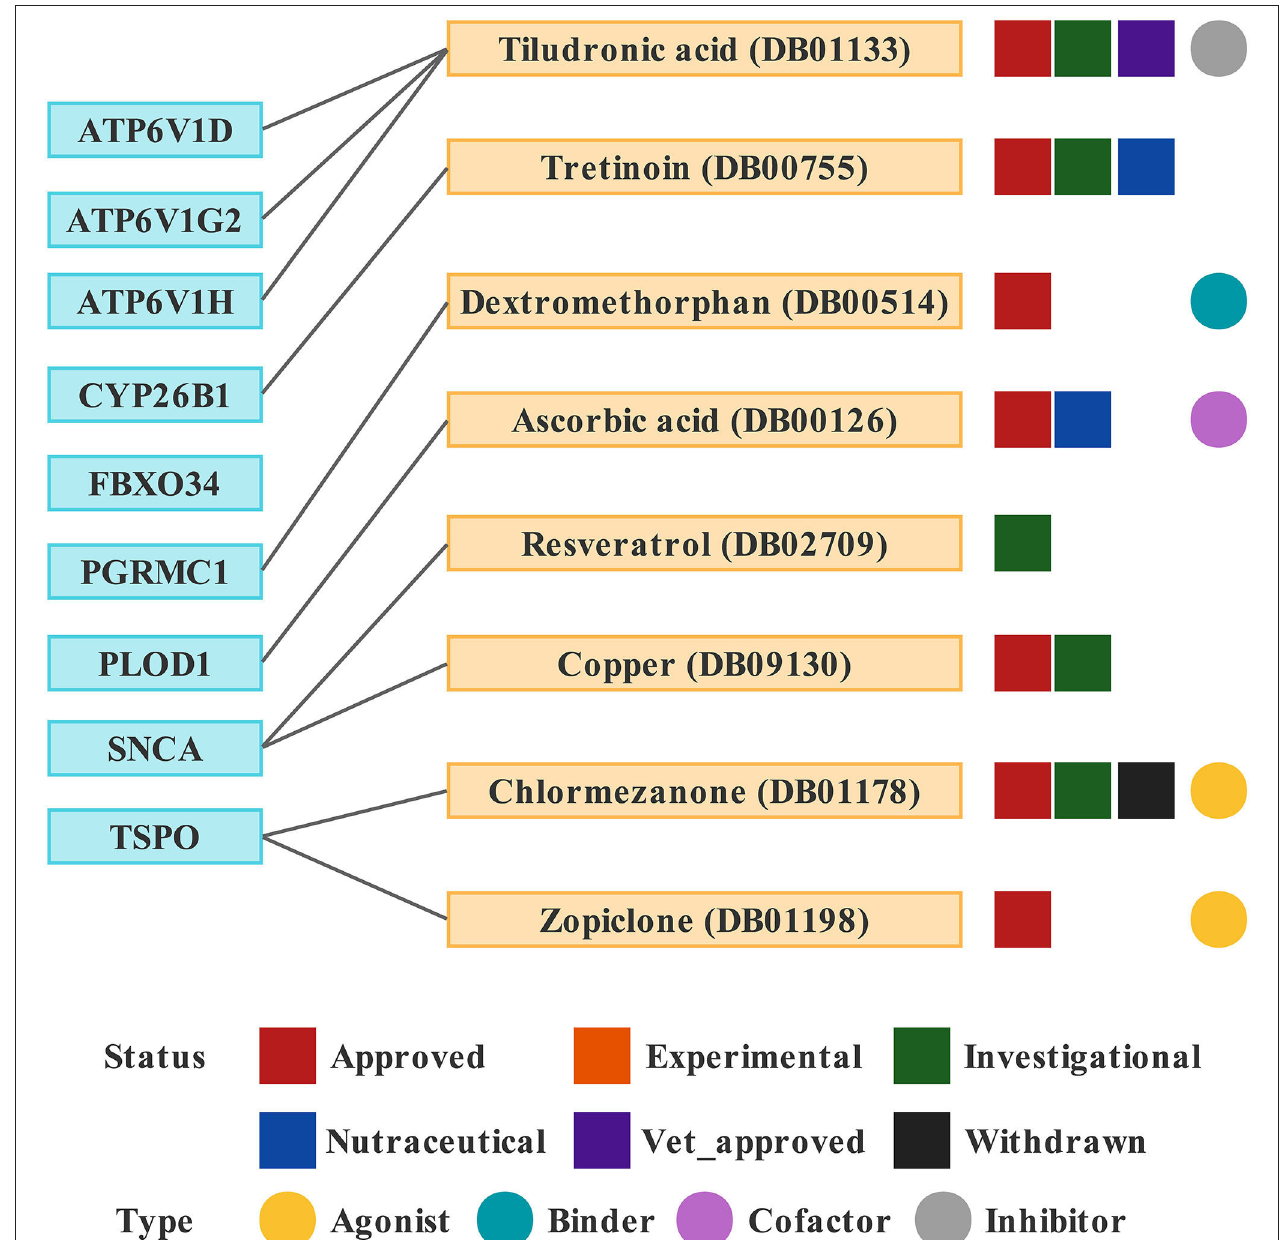
FIGURE 10 | Drugs targeting these nine hub genes obtained from the DrugBank database. Drug statuses, including approved, experimental, investigational, nutraceutical, vet_approved and withdrawn, are indicated by colored squares. Drug types, including agonist, binder, cofactor, and inhibitor, are indicated by colored